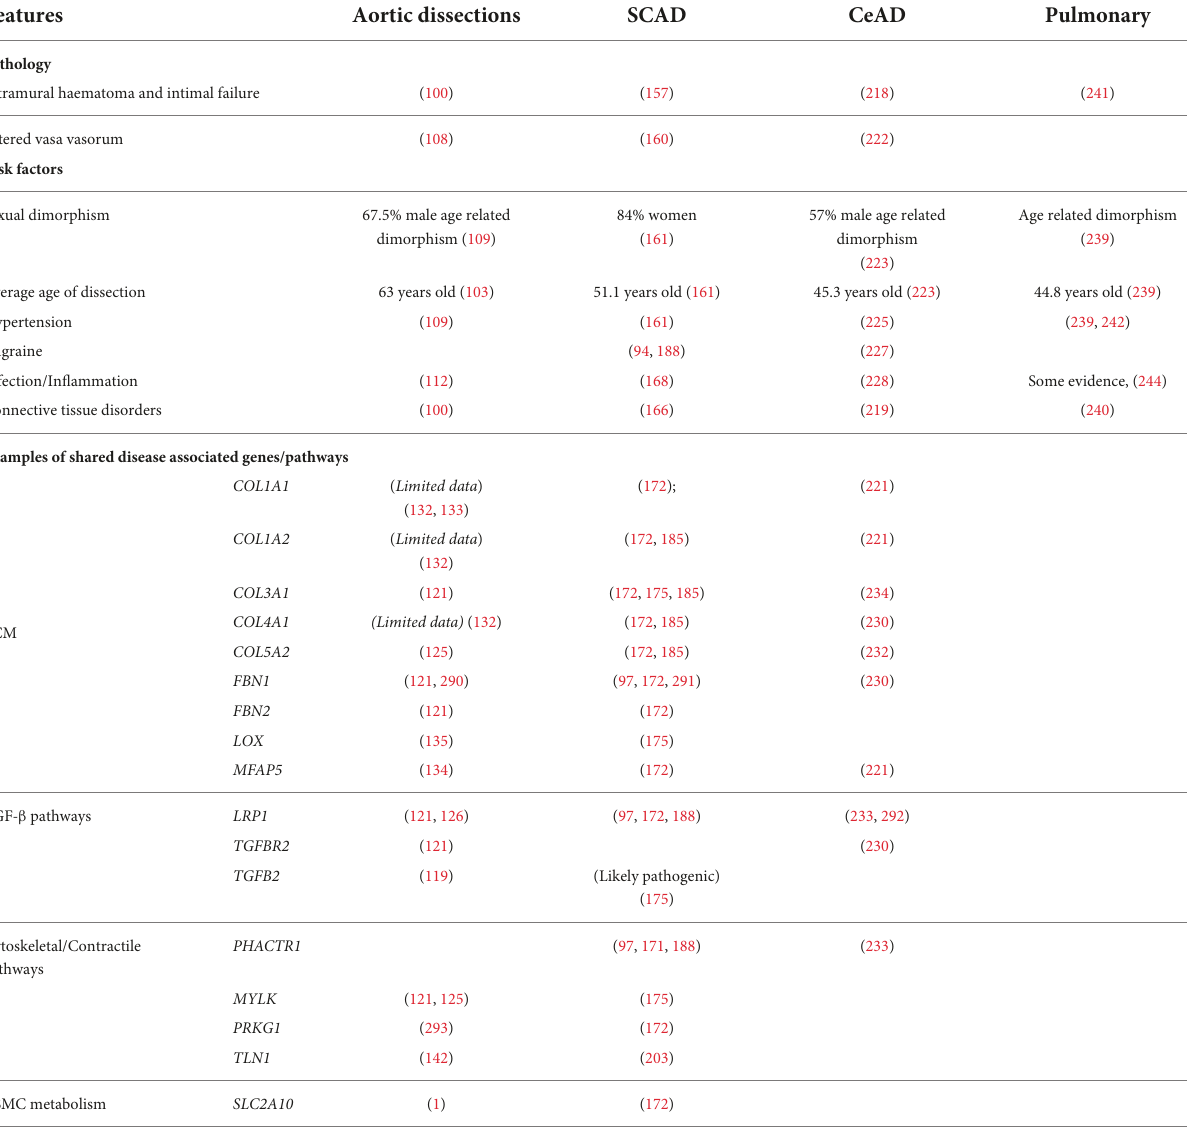
TABLE 2 Common features of arterial